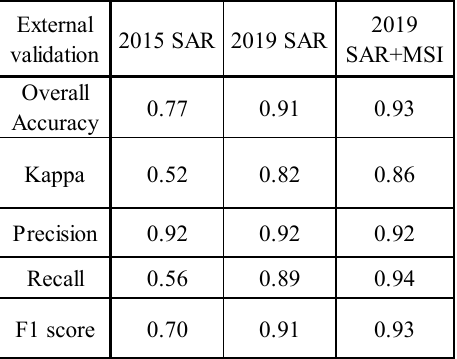
Table 2. External validation metrics for Timeframe 1